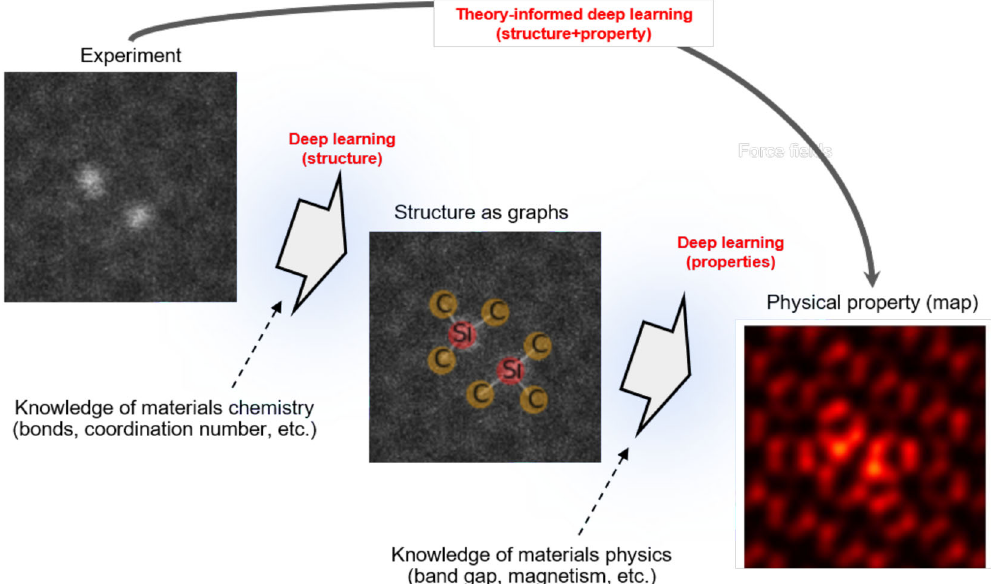
Fig. 5 A simpli fi ed schematic showing analysis of scienti fi c image data using a combination of deep learning and graph modeling for predicting materials (local) structure and properties. Knowledge can be injected at both the structural learning step, as well as the translation from structure to physical properties.